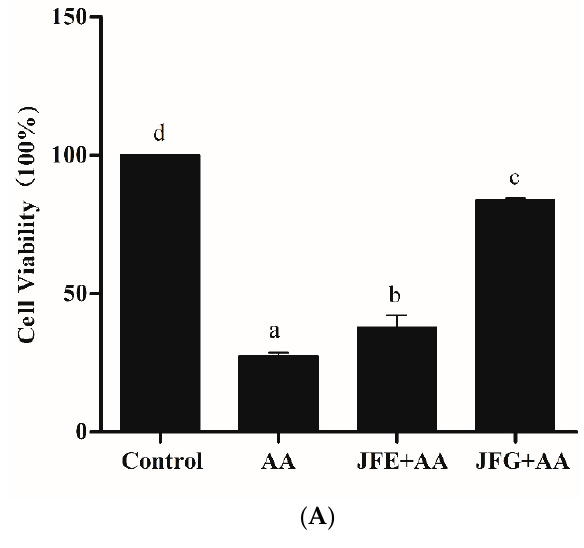
Figure 1. ( A ) In vitro dynamic stomach model: the numbers 1–6 respectively represent stepper motor, timing belt, compression roller, timing belt guide, screw motor, and silicone stomach. ( B ) Representative chromatograms highlighting the compounds characterized before and after the digestion of Jackfruit flake: The chromatogram was obtained using the positive ion mode. ( C ) Mass spectrum of compound ( 6 ) in positive mode. ( D ) Mass spectrum of compound ( 11 ) in positive mode.